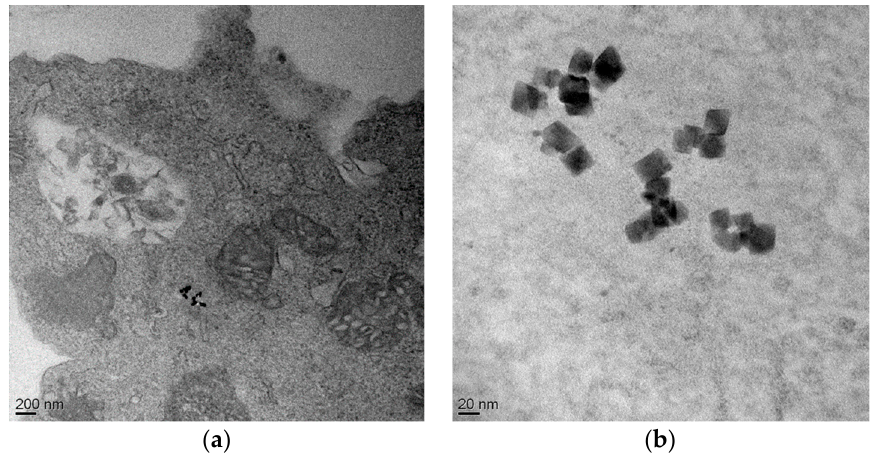
Figure 8. TEM images of SH-SY5Y after incubation with C@HSA-MNPs@rGO, proving the presence of nanohybrid within the cytoplasm.